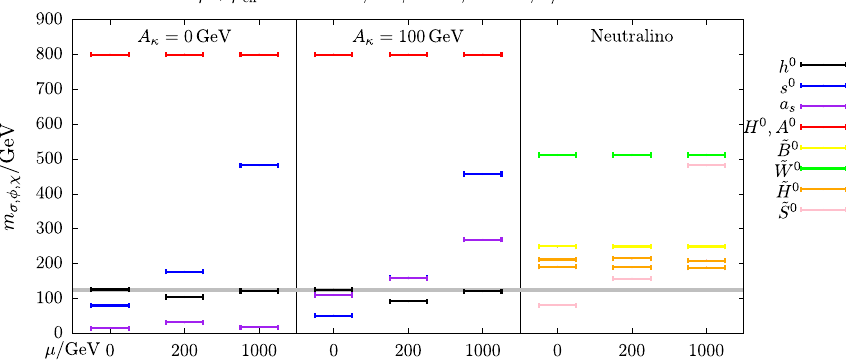
Fig. 2 The loop-corrected Higgs-boson spectrum and the tree-level input m H ± ∼ 800GeV (red) are shown, where the assignments are neutralino spectrum are shown in the μ NMSSM for scenarios with μ ∈ made according to the loop-corrected mixing matrix Z mix for the Higgs ij { 0 , 200 , 1000 } GeV and μ + μ = − 200GeV fixed. The parame- sector, see Sect. 2.4. For the neutralino sector on the right, yellow lines eff show the dominantly bino-like state ˜ B 0 , and green lines the wino-like ters are chosen such that the state h 0 (black) that is mostly SM-like has a mass around 125GeV; the gray band shows a 3GeV inter- state ˜ W 0 . The singlino ˜ S 0 is shown in rose and the two (doublet) hig- val around the experimentally measured Higgs mass. Furthermore, gsinos ˜ H 0 appear in orange. The assignments are determined by the the masses of the CP -even singlet-like state s 0 (blue), the CP -odd tree-level mixing matrix. The parameter values are given in the plot and in Table 1 singlet-like state a s (purple), and the heavy CP -even Higgs doublet and MSSM-like CP -odd components H 0 , A 0 with values close to the